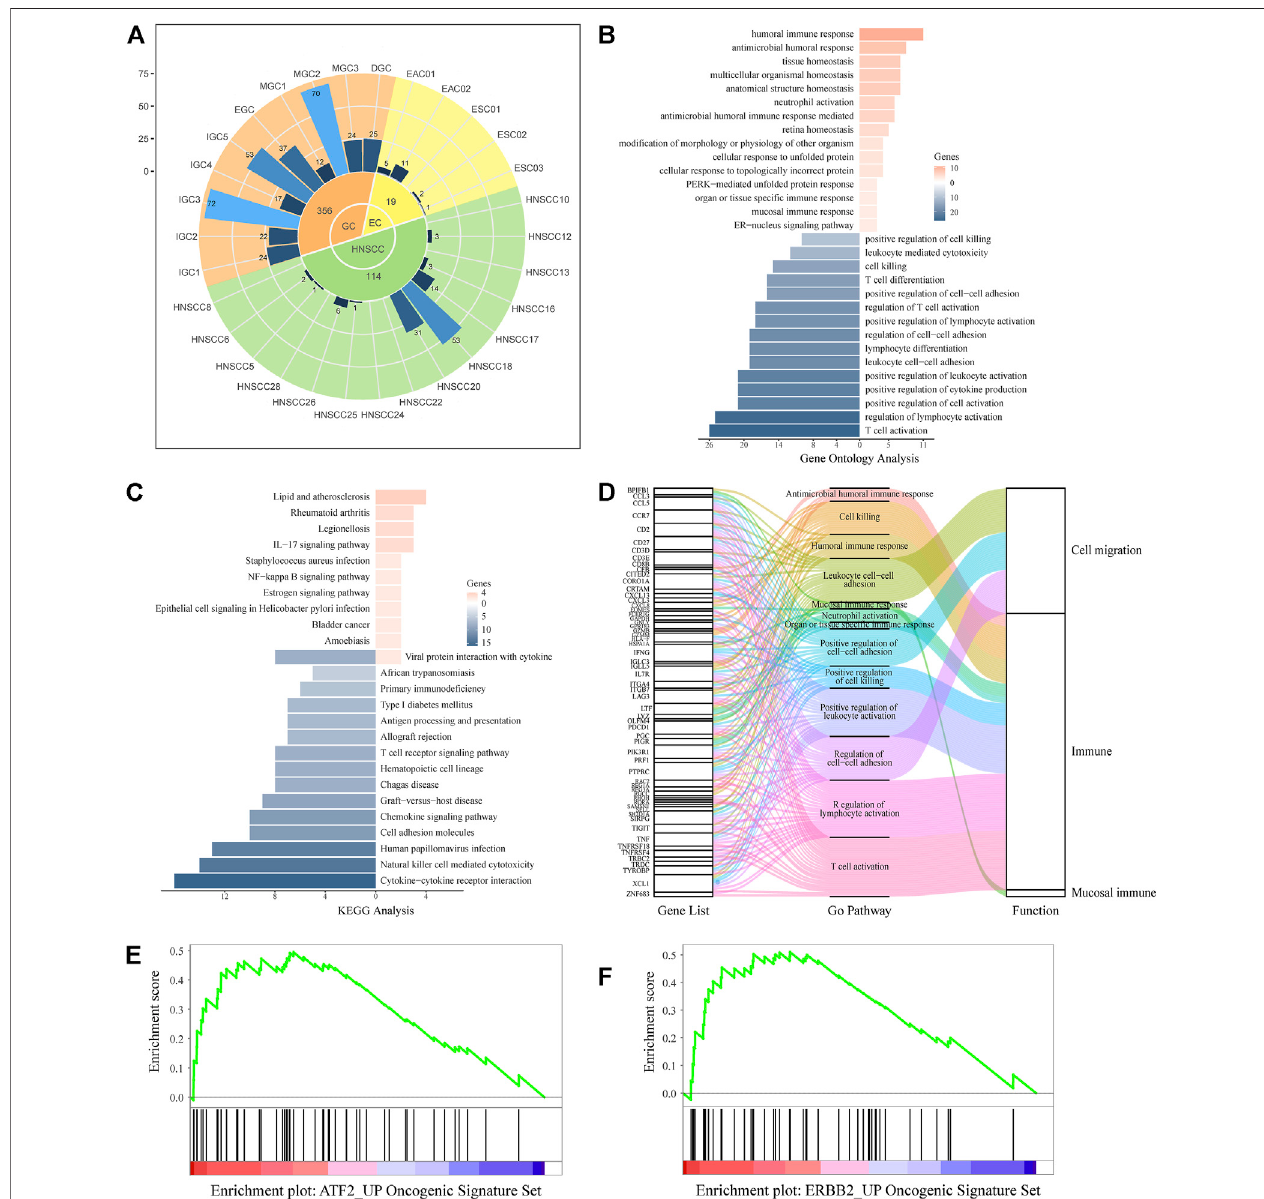
FIGURE4 | UGCSCfunction annotation. (A) Sample source ofUGCSCs. Green, yellow, and orange representHNSCC, EC, and GC, respectively.The inner circle isforthree types ofcancer,and themiddlecircle isthenumber ofcellsineach cancer.Theouter circle represents thenumberofcells ineach sample. (B) Gene ontology functionannotationofUGCSCDEGs. (C) PathwayanalysisofUGCSCdifferentiallyexpressedgenes. (D) GenefunctionintegrationinUGCSCs. (E) UGCSCdifferentially expressed gene set enrichment analysis in the ATF2_UP tumor set. (F) UGCSC differentially expressed gene set enrichment analysis in the ERBB2_UP tumor set.